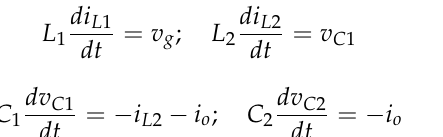
Figure 3. (a) Switching state when s 1 =1 and s 2 =1 , (b) Switching state when s 1 =0 and s 2 =0 . Figure 3. ( a ) Switching state when s 1 = 1 and s 2 = 1, ( b ) Switching state when s 1 = 0 and s 2 = Those switching states lead to two different mathematical models; by following the Kirchhoff voltage law (KVL) and the Kirchhoff current law (KCL), the mathematical model of the circuit shown in Figure 3a is given by (1)–(2).